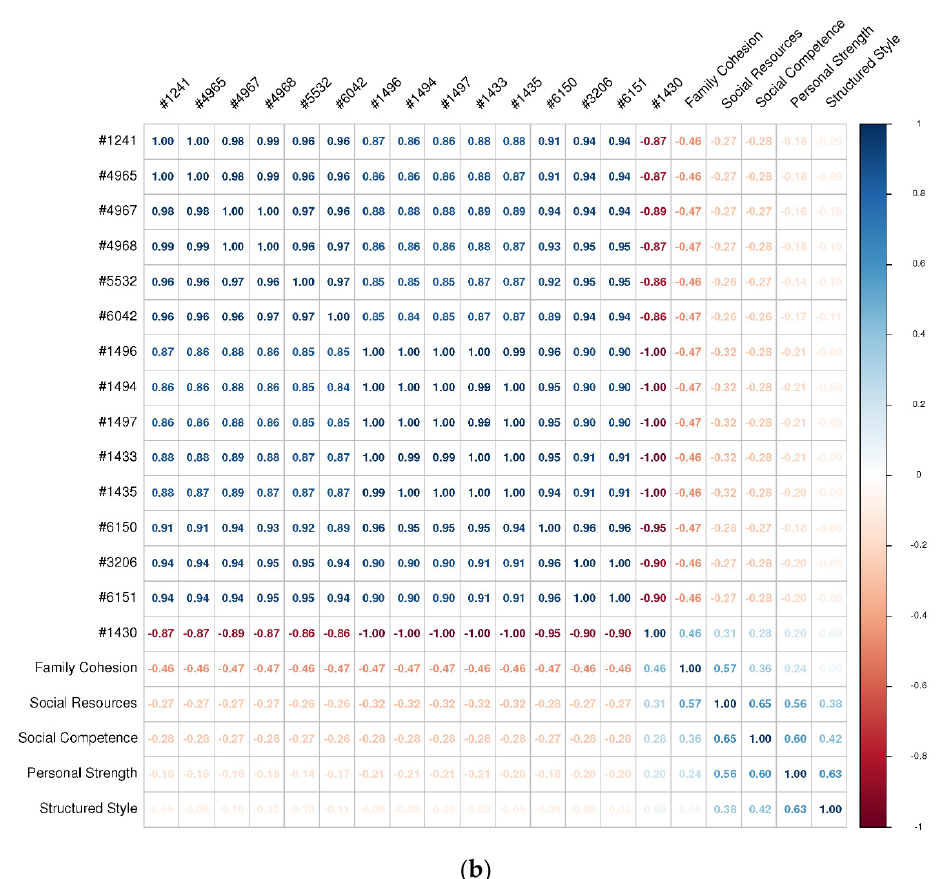
ComParE2013 paralinguistic feature (positive & negative memories). Because there were many statis-